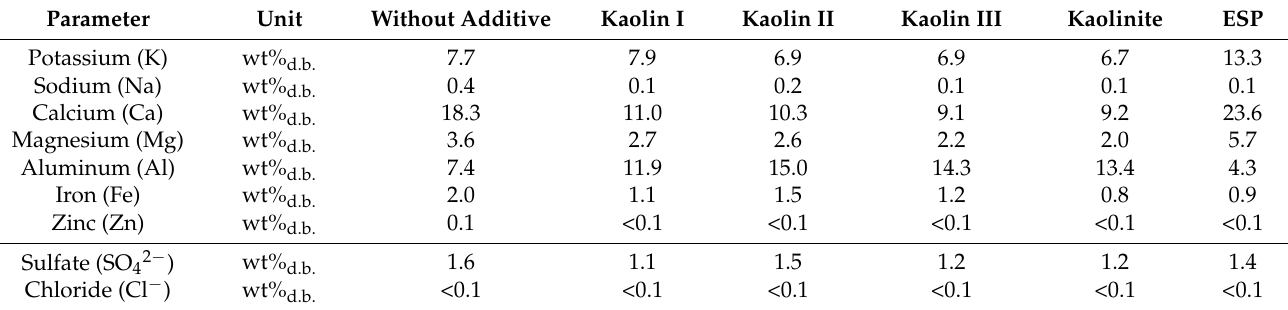
Table 5. Crystalline phases of the ashes for the combustion of non-additivated (without and